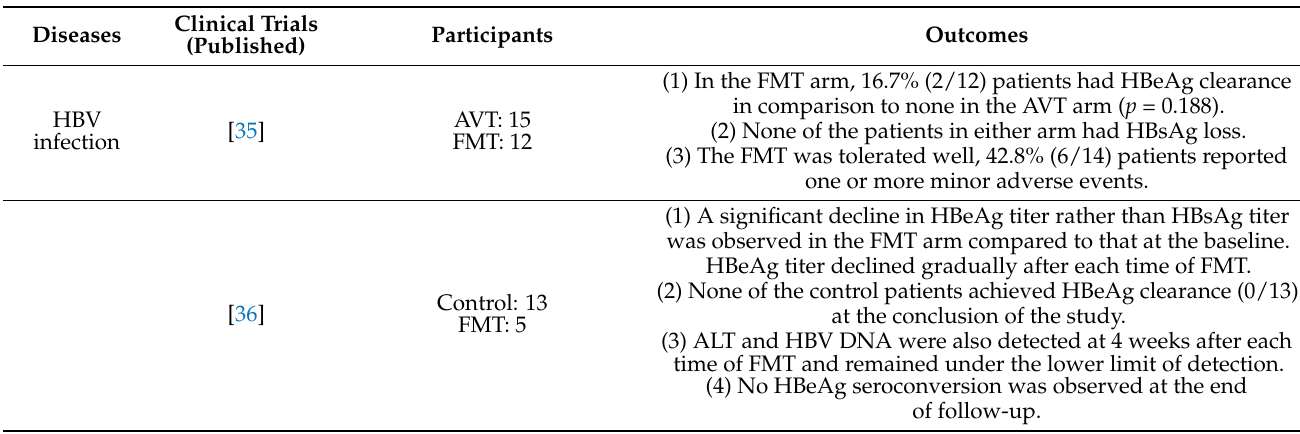
Table 1. Studies related to the application of FMT in the treatment of liver diseases (without case reports). Clinical Trials Diseases